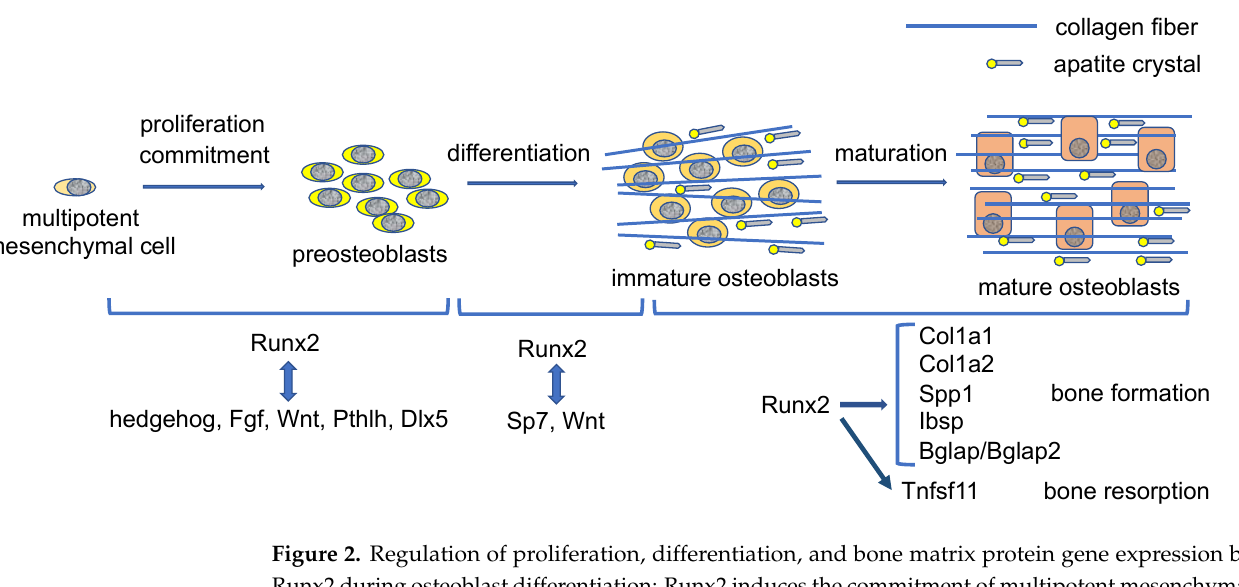
Figure 2. Regulation of proliferation, differentiation, and bone matrix protein gene expression by Runx2 during osteoblast differentiation: Runx2 induces the commitment of multipotent mesenchymal cells to preosteoblasts and enhances the proliferation of osteoblast progenitors by inducing the expressions of hedgehog, fibroblast grow factor (Fgf), Wnt, and Pthlh signaling pathway genes and distal-less homeobox 5 (Dlx5), which also enhance Runx2 expression and Runx2 protein activity. Runx2 also induces Sp7 expression. Runx2, Sp7 and Wnt signaling induce the differentiation of preosteoblasts into immature osteoblasts. Sp7 and Wnt signaling activate the osteoblast-specific Runx2 enhancer. In immature osteoblasts, Runx2 induces the expressions of bone matrix protein genes, including Col1a1, Col1a2, Spp1, Ibsp, and bone gamma carboxyglutamate protein (Bglap)/Bglap2, and the osteoblasts maturate and produce abundant bone matrix proteins. Runx2 also induces tumor necrosis factor superfamily member 11 (Tnfsf11) expression and enhances bone resorption. Osteocalcin (Bglap/Bglap2) aligns the apatite crystals parallel to collagen fibers. The collagen fibers run along the longitudinal direction in the dialysis of long bone, which is formed by mature osteoblasts, whereas collagen fibers run irregularly in metaphyseal cortical bone in young mice, which is formed by immature osteoblasts. However, apatite crystals are always aligned parallel to the collagen fibers by osteocalcin [63].